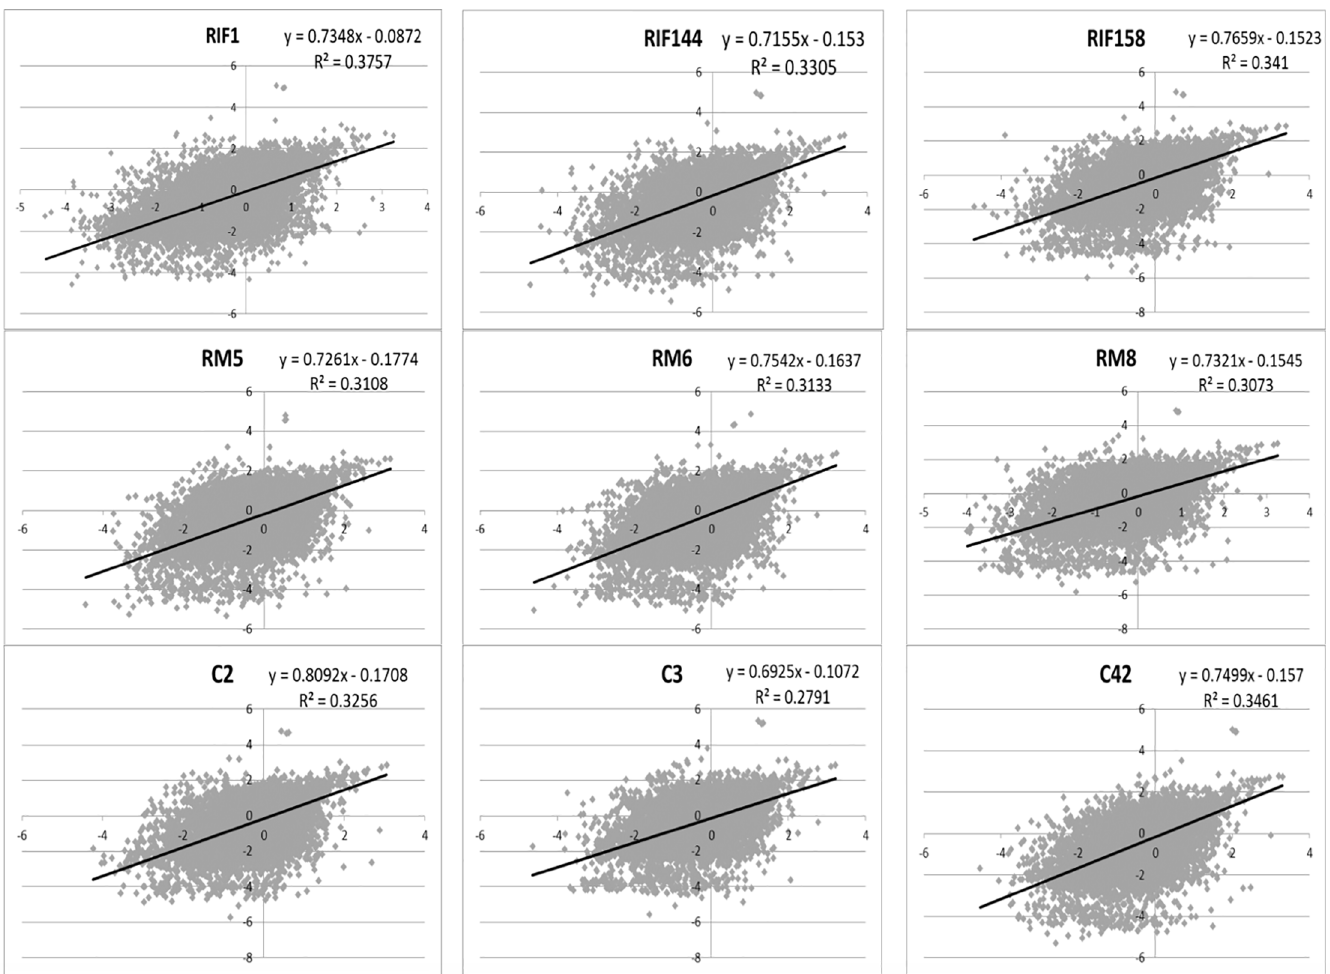
Fig 3. Scattered plots showed positive correlation of transcriptome in paired samples of each subjects. RIF: recurrent implantation failure; RM: recurrent miscarriage; C: fertile control.